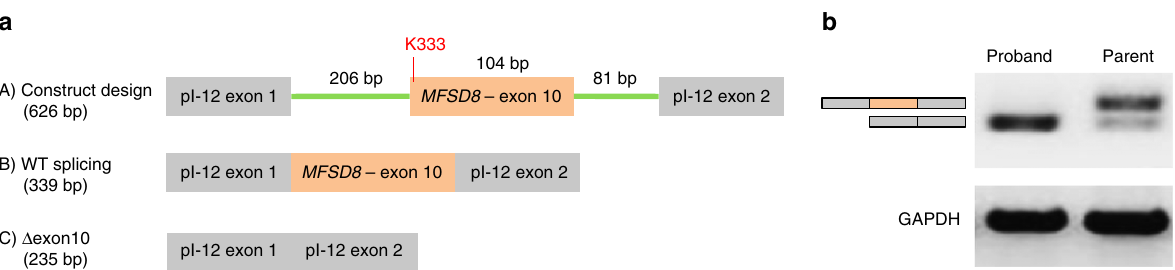
Fig. 5 Mini-gene design and quanti fi cation. a Minigene design. (A) Exon 10 and fl anking genomic sequence was ampli fi ed from patient and parent DNA and cloned into the pI-12 splicing reporter vector. (B) Predicted splicing effect if splice site mutation has no effect on WT splicing. (C) Predicted skipping of exon 10 if splice site is disrupted by K333. b Semi-quantitative PCR gel of splicing isoforms of parent harboring the W97C variant and proband harboring both the W97C and K333